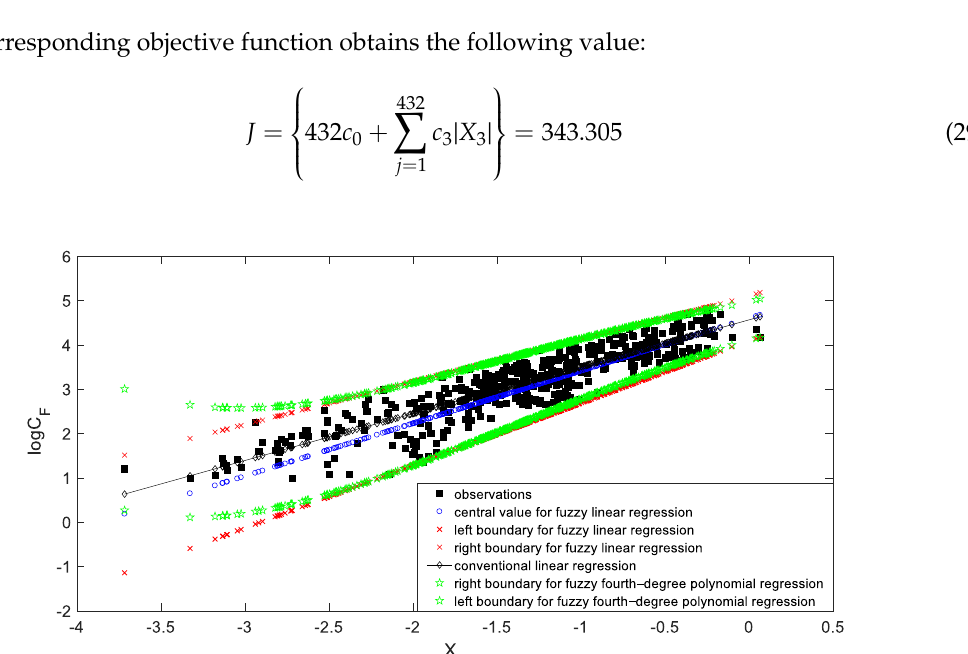
Figure 3. Fuzzy linear regression to achieve the log of the total sediment concentration with respect to X 3 .